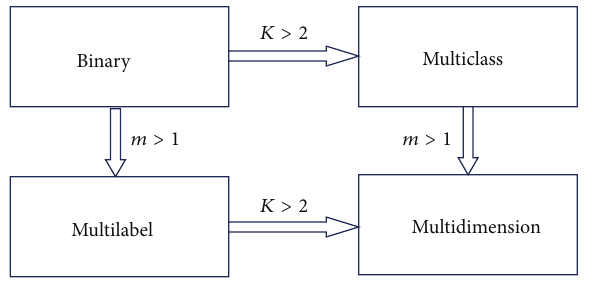
Figure 1: The relationship among different classification